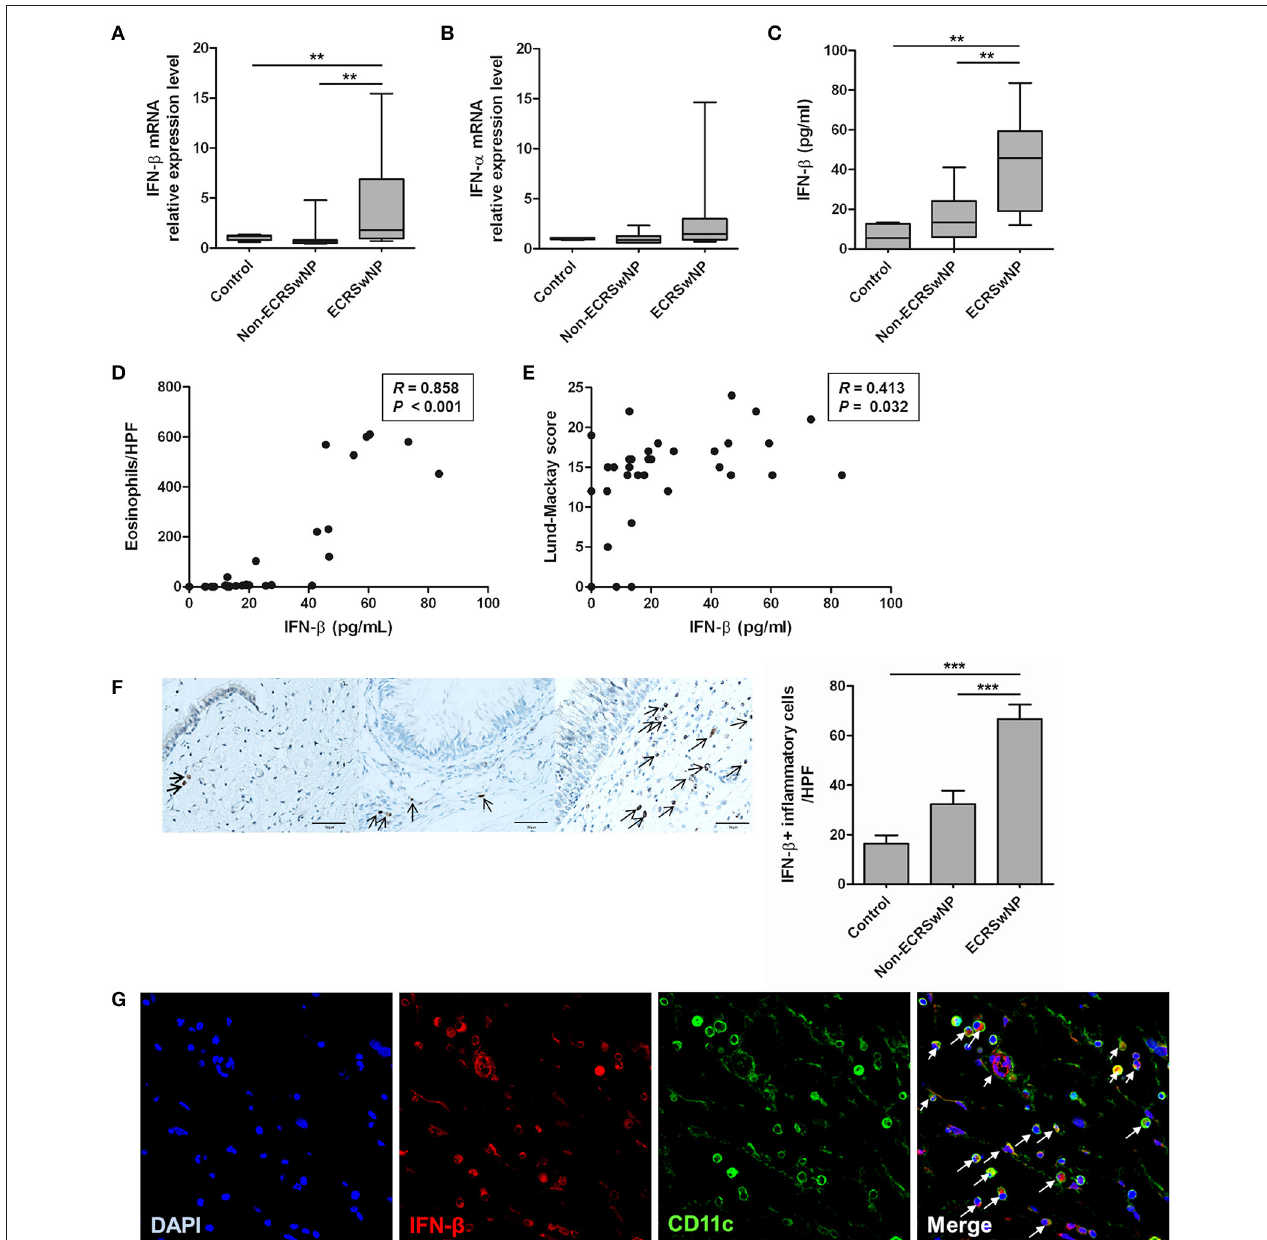
FIGURE 1 | Expression of type I IFN in human sinonasal tissue. (A,B) IFN- β mRNA and protein levels are enhanced in tissue homogenates from eosinophilic CRS with NP (ECRSwNP) patients. (C) On the other hand, there are no differences in the IFN- α family mRNA expression between control, non-eosinophilic CRSwNP (non-ECRSwNP), and ECRSwNP groups. (D,E) IFN- β level positively correlated with the number of eosinophils in the sinonasal tissue and Lund-Mackay CT score in 31 patients with CRSwNP. (F) In addition, IFN- β + cells (indicated by arrows) are more frequently detected in the lamina propria of ECRSwNP tissues compared with the controls and non-ECRSwNP (magnification, × 400; scale bar, 50 µ m). Horizontal bars indicate the medians. ** P < 0.01; *** P < 0.001, repeated measurement ANOVA with Tukey’s multiple comparison test (A–C,F) and Spearman correlation test (D,E) . (G) In immunofluorescence assay for NP tissue, IFN- β (red fluorescence) was frequently detected in CD11c cells (green fluorescence). Nuclei were counterstained with 4’,6-diamidino-2-phenylindole (DAPI; blue fluorescence). In the merged image, cells indicated by arrows show co-localization of IFN- β and CD11c cells. The immunofluorescence results are representative of 5 different subjects (Magnification, × 400).